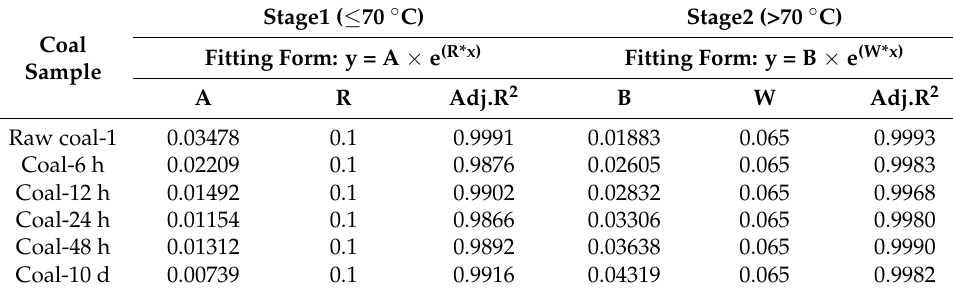
Figure 5. ( a ) O 2 . ( b ) CO. Variation in O 2 and CO concentration. Table 2. Function fitting of CO production with